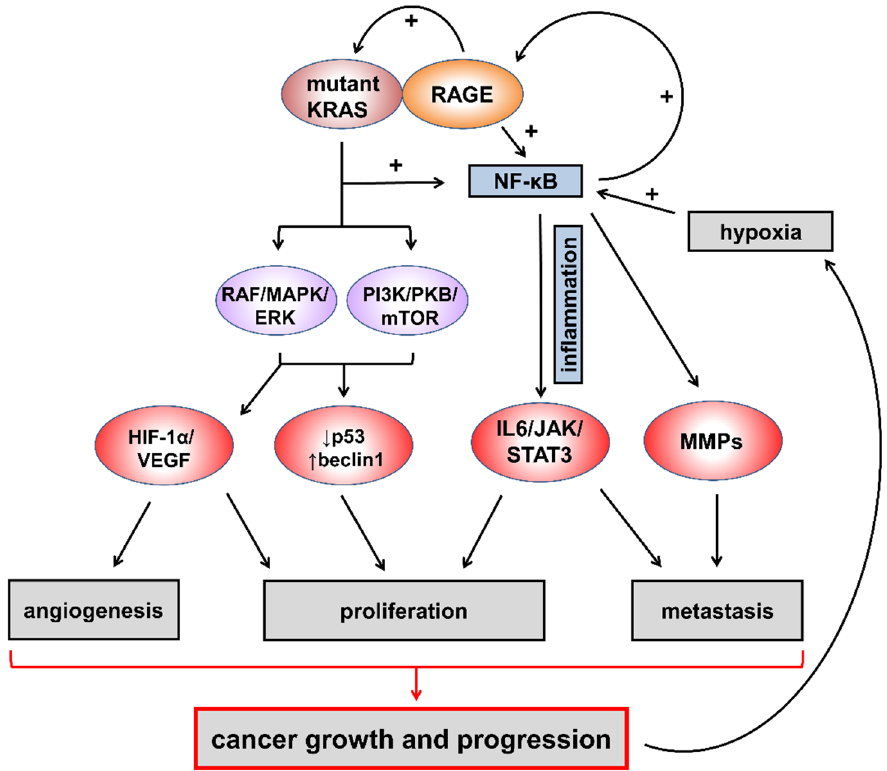
Figure 5. RAGE signaling cooperates with mutant KRAS in pancreatic cancer development and progression. RAGE signaling results in upregulation of several KRAS-dependent pathways playing a critical role in PDAC development and progression. RAGE = receptor for advanced glycation end-products; NF- κ B = nuclear factor- κ B; RAF/MAPK/ERK = rapidly accelerated fibrosarcoma/mitogen-activated protein kinase/extracellular signal-regulated kinases; PI3K/PKB/mTOR = phosphoinositide 3-kinase/protein kinase B/mammalian target of rapamycin; HIF-1 α /VEGF = hypoxia-inducible factor 1 α /vascular endothelial growth factor; p53 = tumor protein P53; IL6/JAK/STAT3 = interleukin 6/janus kinase/signal transducer and activator of transcription 3; MMPs = matrix metalloproteinases. Despite the bulk of evidence indicating a role of RAGE in PDAC, only one study